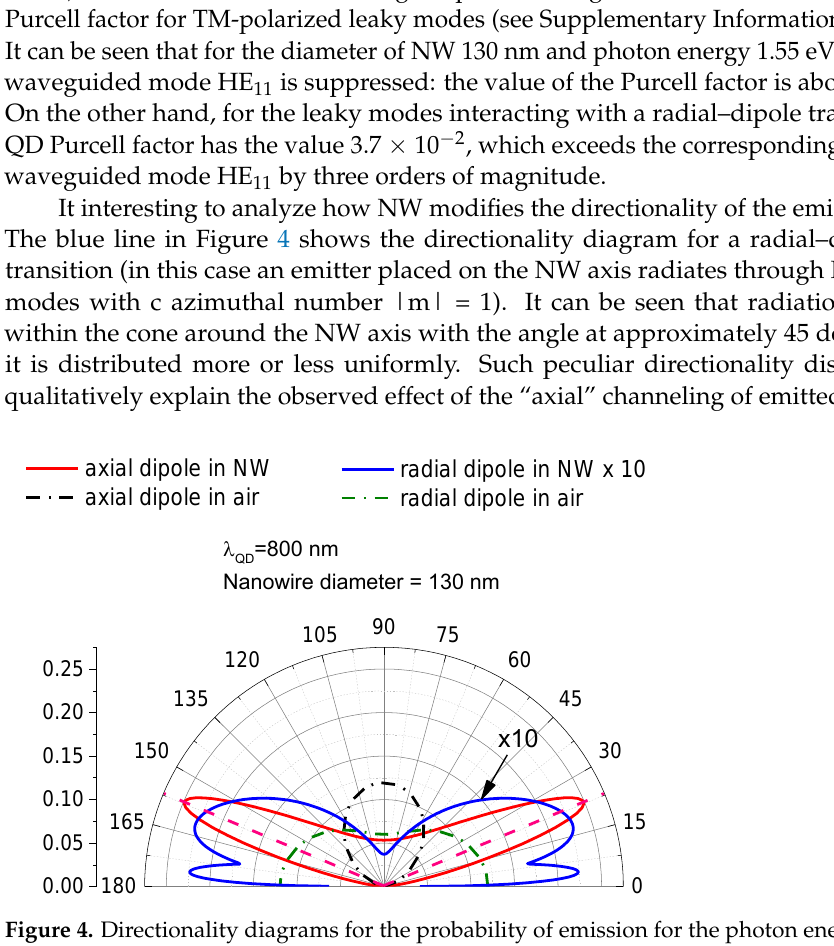
Figure 4. Directionality diagrams for the probability of emission for the photon energy 800 nm for the emission of axial dipole (red line) and for radial dipole (blue line). For radial directionally, the diagram is averaged by rotating it around an axis of NW. Dashed black and green lines show the emission of an axial dipole and for the radial dipole in air, respectively. The axis of the nanowire corresponds to the direction 0 – 180 degrees.